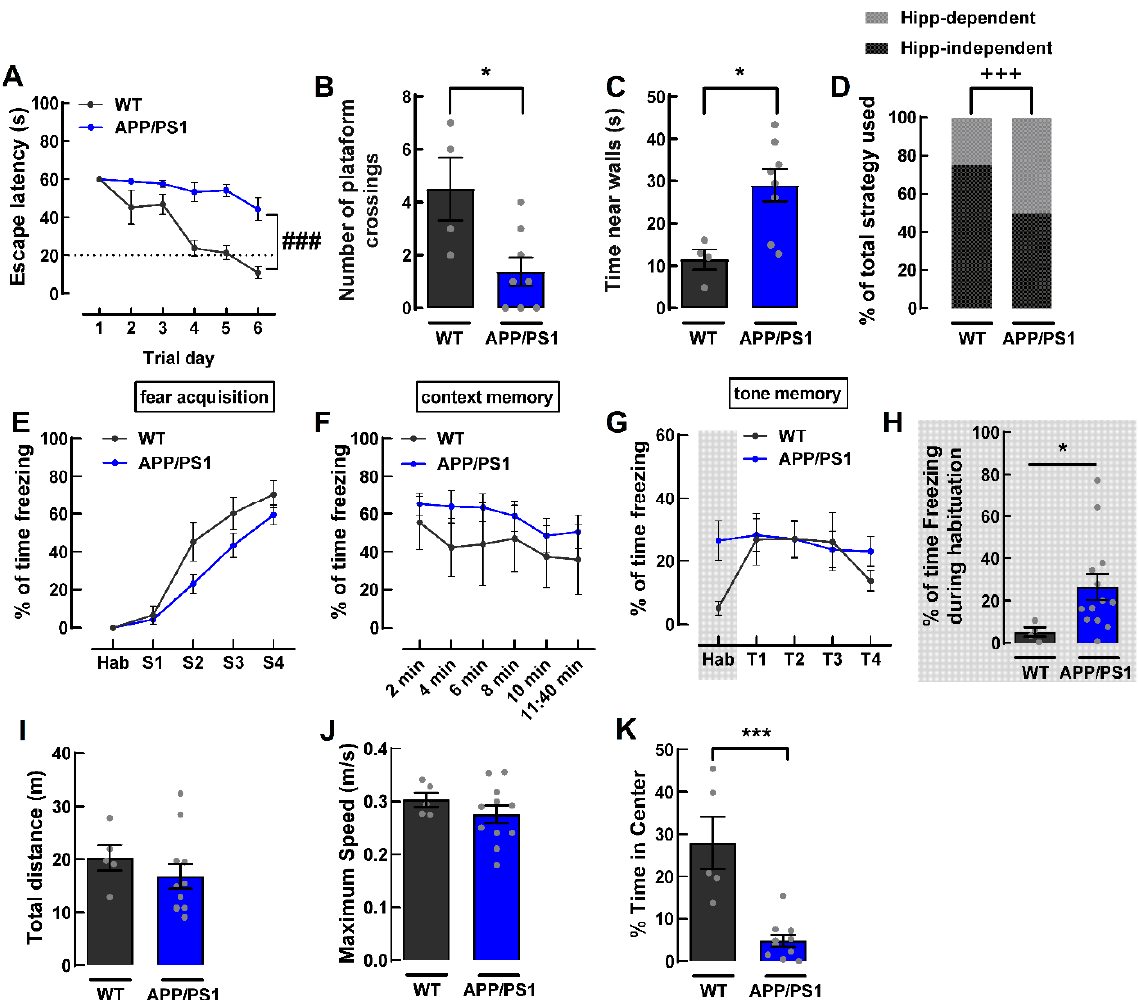
Figure 2. Behavioral characterization of 8–9-month-old female APP/PS1 mice. ( A ) Acquisition/learning in the Morris water maze (MWM) test was assessed by measuring the latency to reach the platform during the 6 days of the test; APP/PS1 mice displayed learning deficits. ( B ) Num- ber of crossings in the platform site in the probe day of the MWM, showing reference memory deficits in APP/PS1 mice. ( C ) Time spent swimming close to the walls in the MWM, showing that APP/PS1 mice did more thigmotaxic swim. ( D ) Percentage of animals that used a hippocampus-dependent versus a non-hippocampus dependent search strategy for the platform during the probe trial in the MWM; APP/PS1 mice used significantly less hippocampus-dependent strategies than the WT mice. There was no difference in fear acquisition and memory, as shown in: ( E ) fear acquisition in the cued (tone) fear conditioning test represented as the percentage of time freezing; ( F ) Percentage of time freezing in the same context 24 h post-acquisition; and ( G ) percentage of time freezing upon presentation of the same tone, but in a different context. ( H ) Percentage of time spent in freezing during habituation phase, showing increased freezing, suggestive of fear generalization. ( I ) There was no difference in locomotion, as total distance travelled in the open field and ( J ) the maximum speed reached in meters by seconds were similar between APP/PS1 and WT mice. ( K ) Percentage of time spent in the center of the open field, showing increased anxiety-like behavior in APP-PS1 mice. Data are mean ± SEM of 4–13 animals. ### p < 0.001, by a Two-way ANOVA test; * p < 0.05 and *** p < 0.001 by a Student’s unpaired t -test; +++ p < 0.001, Chi-square